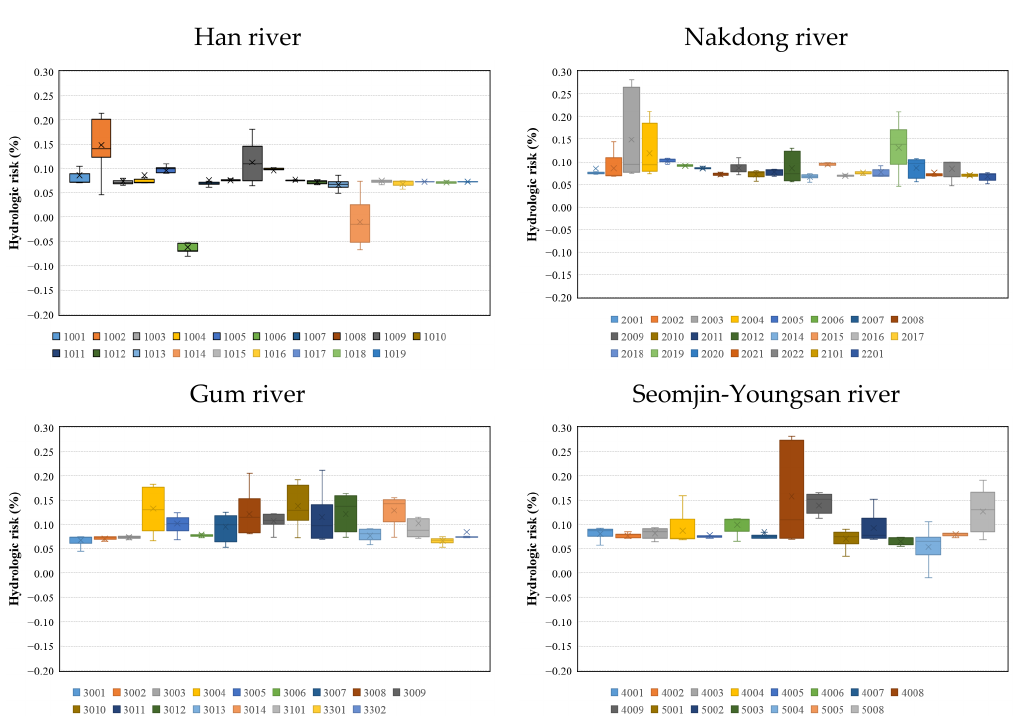
Figure 9. Hydrologic risks of individual basins according to the RCP 8.5.